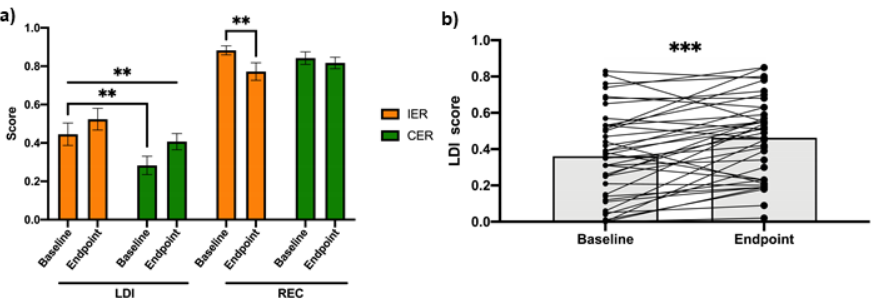
Figure 2. Energy restriction improves pattern separation regardless of method. ( a ) There is no significant di ff erence between IER and CER in pattern separation and recognition memory performance, as measured by LDI and REC scores, respectively. However, the IER group had a significant reduction in REC score ( P = 0.007), which was not observed in the CER group. ( b ) When the groups are treated as a single cohort, there is a significant increase in LDI score ( P = 0.0005). Significance at P < 0.05. ** P < 0.01, *** P < 0.001. IER: intermittent energy restriction; CER: continuous energy restriction